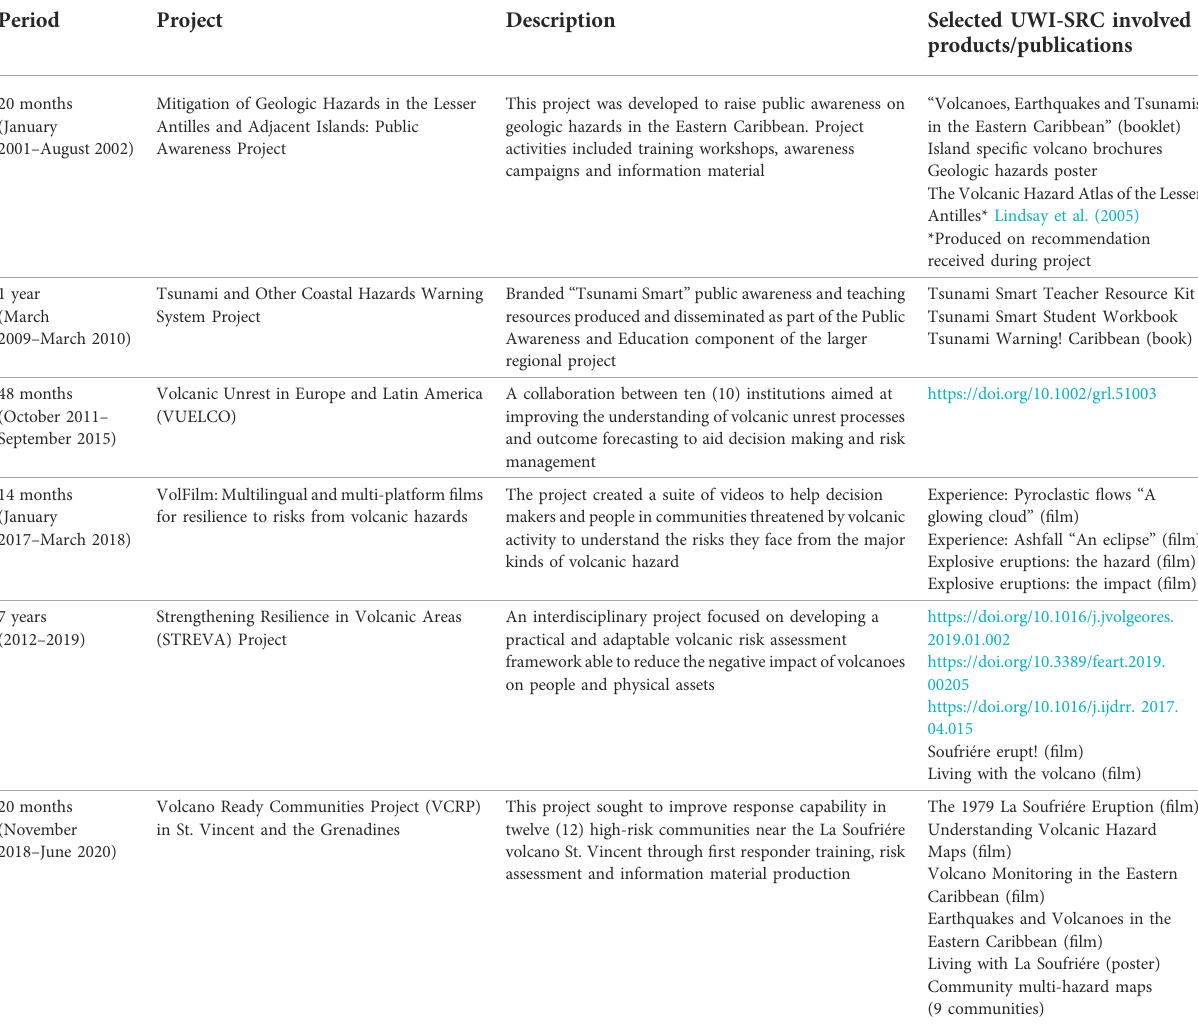
TABLE 2 Interdisciplinary projects involving The UWI Seismic Research Centre since